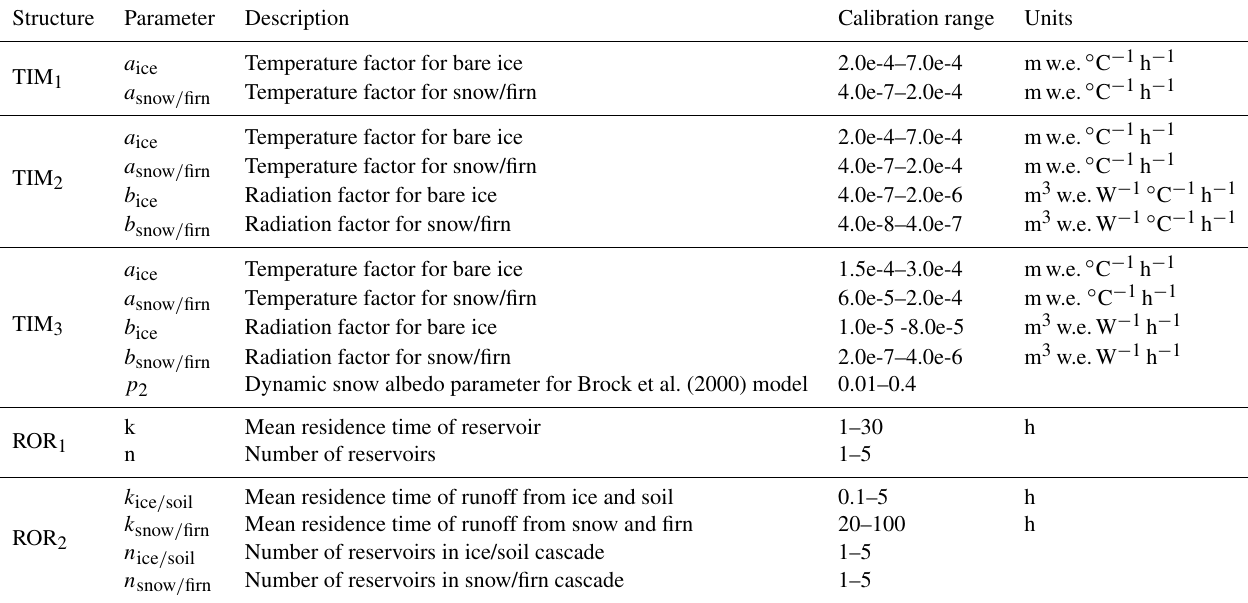
Table C1. Calibration parameters for the melt and runoff-routing model structures.